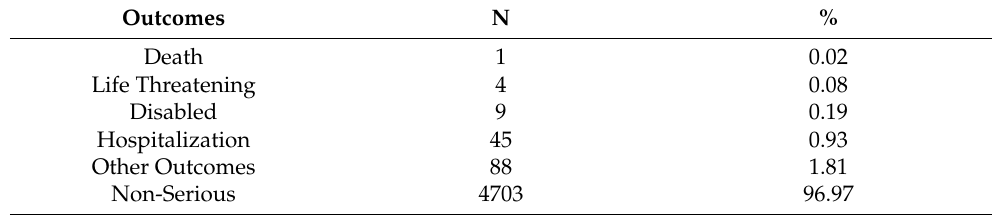
Table 4. Clinical outcomes of patients with disease recurrence after nirmatrelvir/ritonavir